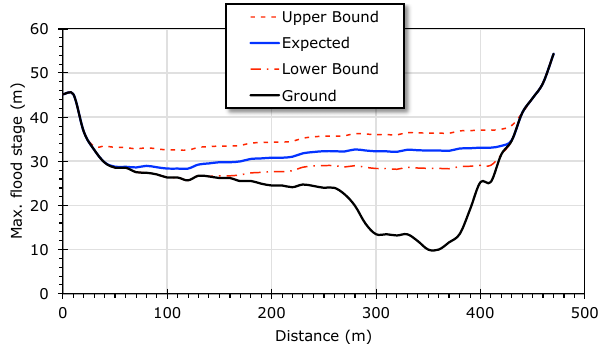
Figure 5. Upper bound, expected and lower bound GLOF flood stage at Dingboche (cross section shown in Figure 4) under current conditions .